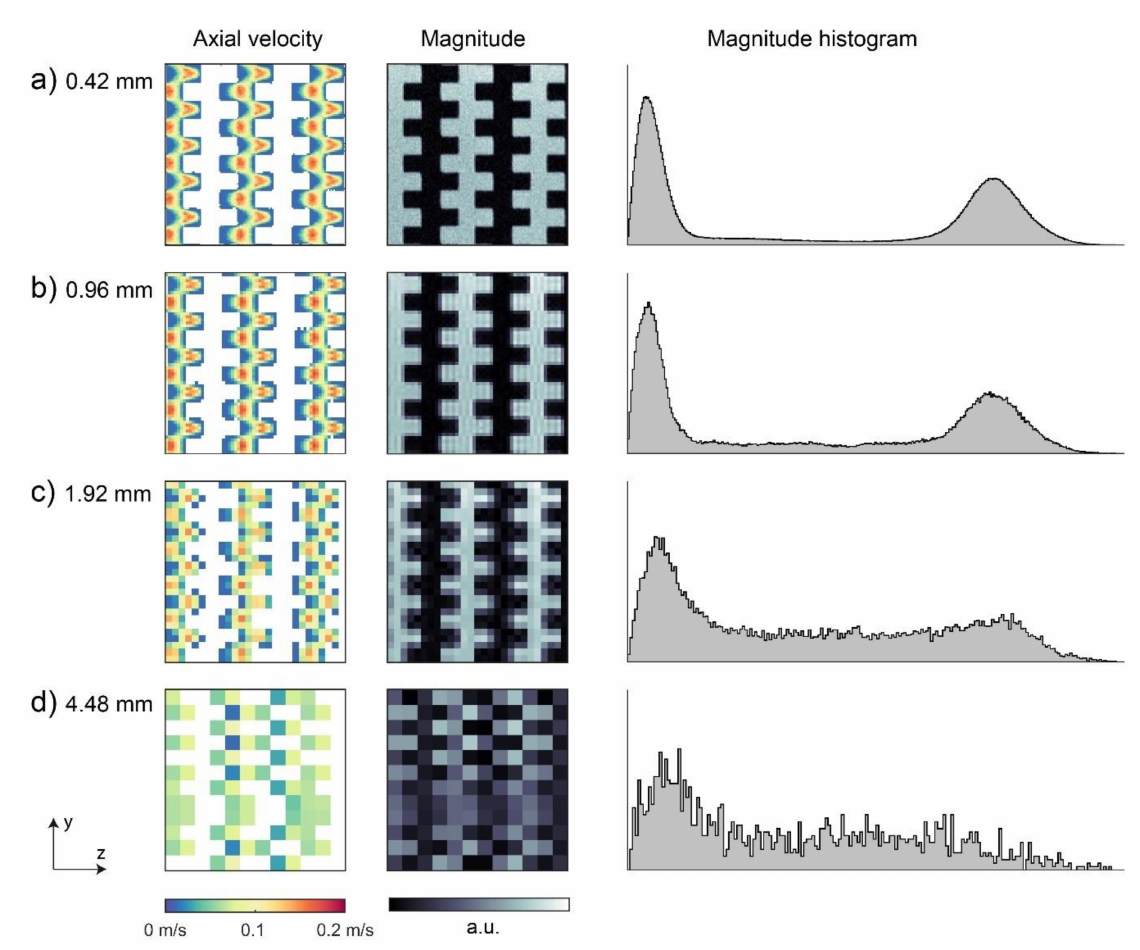
Figure 8. Velocity field for voxel sizes of 0.42 mm ( a ), 0.96 mm ( b ), 1.92 mm ( c ), and 4.48 mm ( d ) shown for: axial velocity ( u z ) in a selected (50 mm × 50 mm) slice ( left column ), magnitude data used for image segmentation ( middle column ), and magnitude histograms of the central (50 mm × 50 mm × 50 mm) volume of the porous cube ( right column